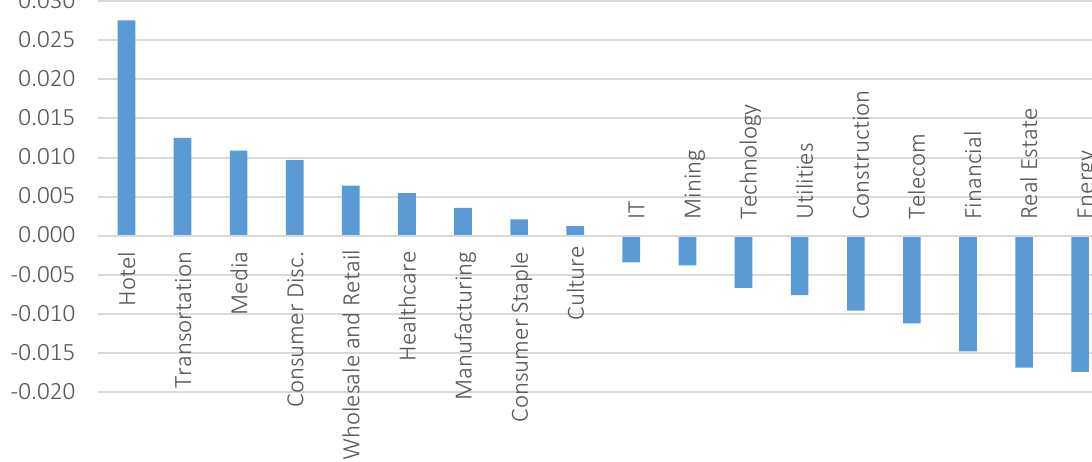
Figure 1. Average stock price changes for different